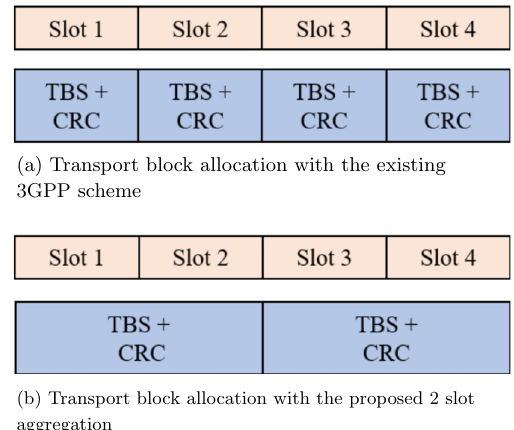
Fig. 7 Comparison of the proposed transport-block scaling with the existing 3GPP